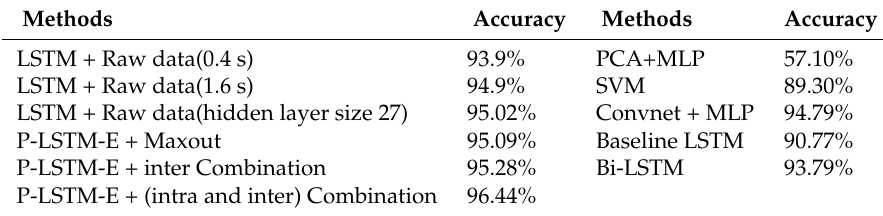
Figure 4. Accuracies of intra-classifier combination with different time window sizes. The intra-classifier combination accuracies of classifier 1 ( a ), 2 ( b ), 3 ( c ), 4 ( d ), 5 ( e ), 6 ( f ) corresponding to activity 1, 2, 3, 4, 5, 6 in UCI-HAR data-set. Table 3. Performance